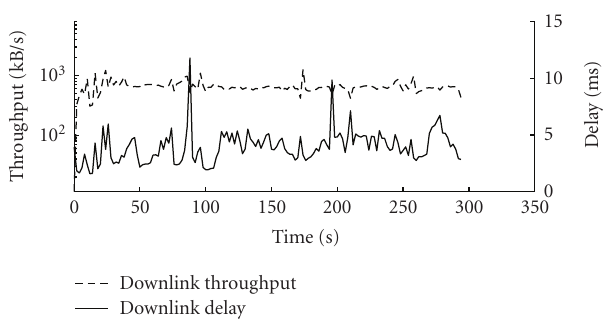
Figure 12: Downlink throughput and delay when the game has higher priority than the background tra ffi